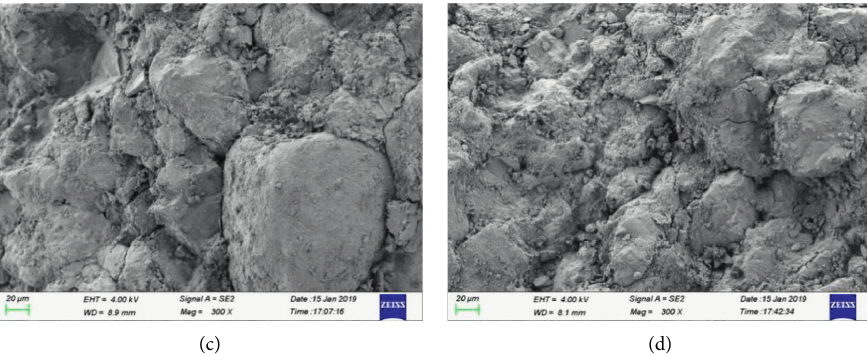
Figure 4: Scanning electron microscope images of rock samples before and after freeze-thaw ( × 300). (a) 0 cycles, (b) 10 cycles, (c) 20 cycles, and (d) 30